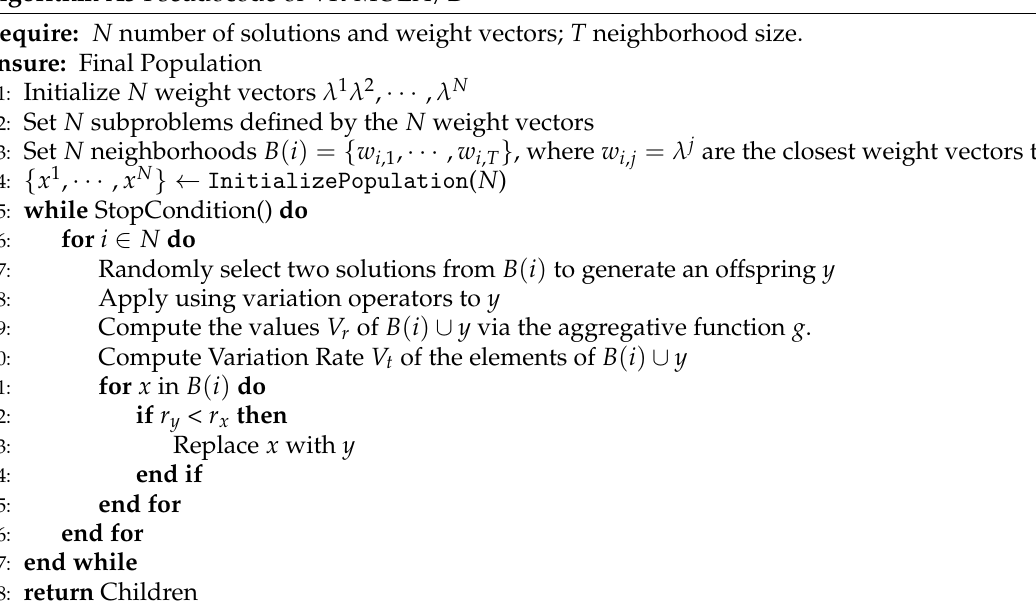
Algorithm A3 Pseudocode of